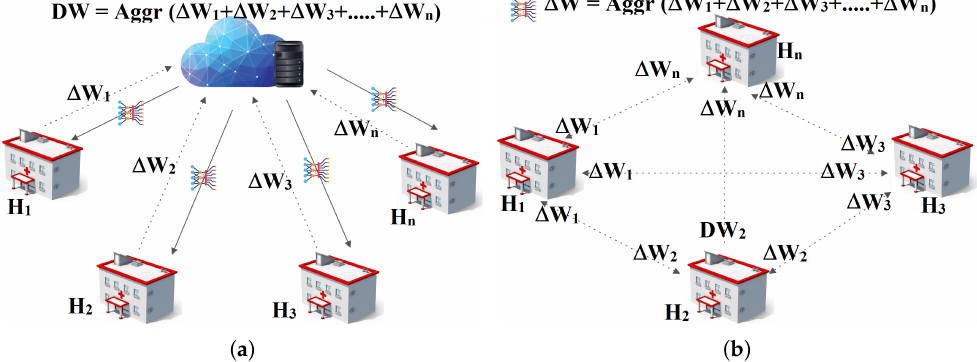
Figure 1. The two views of FL aggregation. ( a ) CFL Architecture [26]; ( b ) DFL Architecture [27]. Table 1. A comparative analysis of CFL and DFL